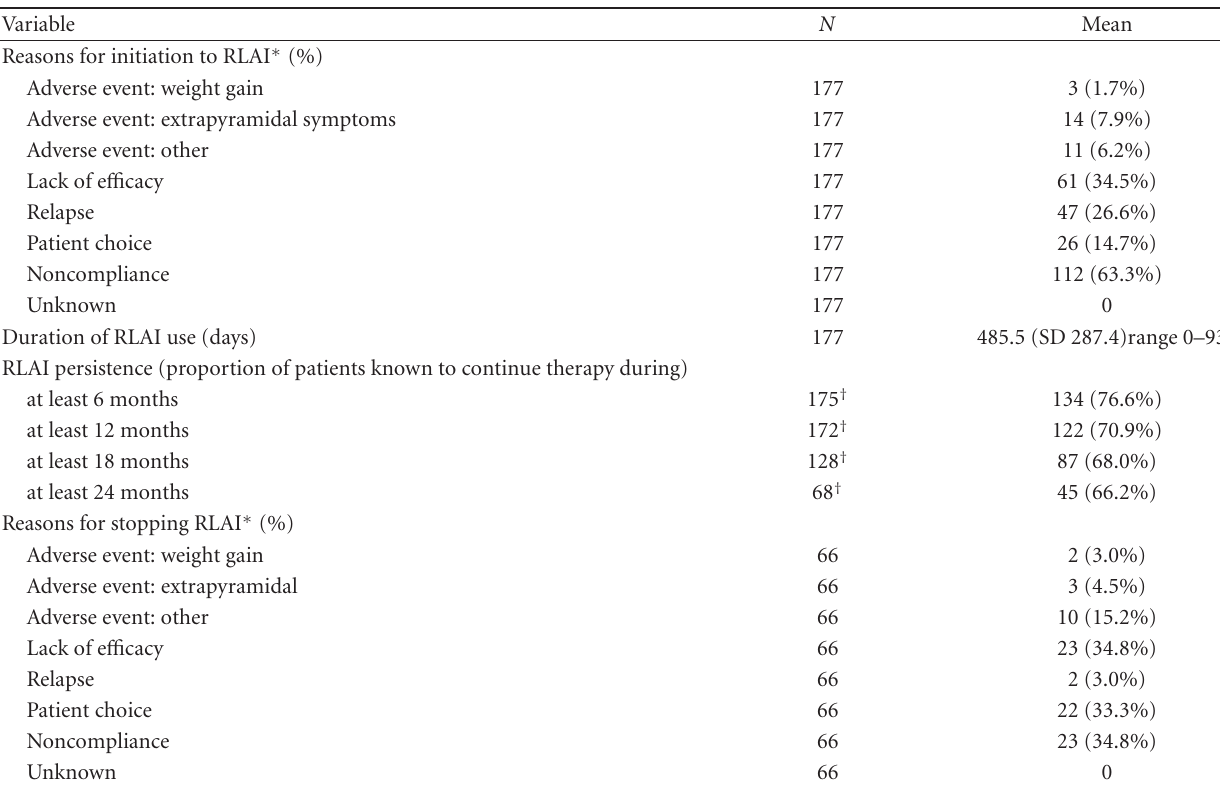
Table 3: Use of RLAI.